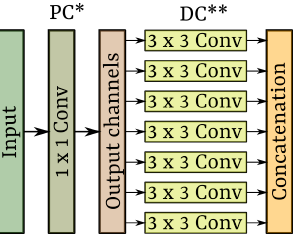
Figure 9. A module of a Xception architecture. * Poinwise convolution; ** Depthwise